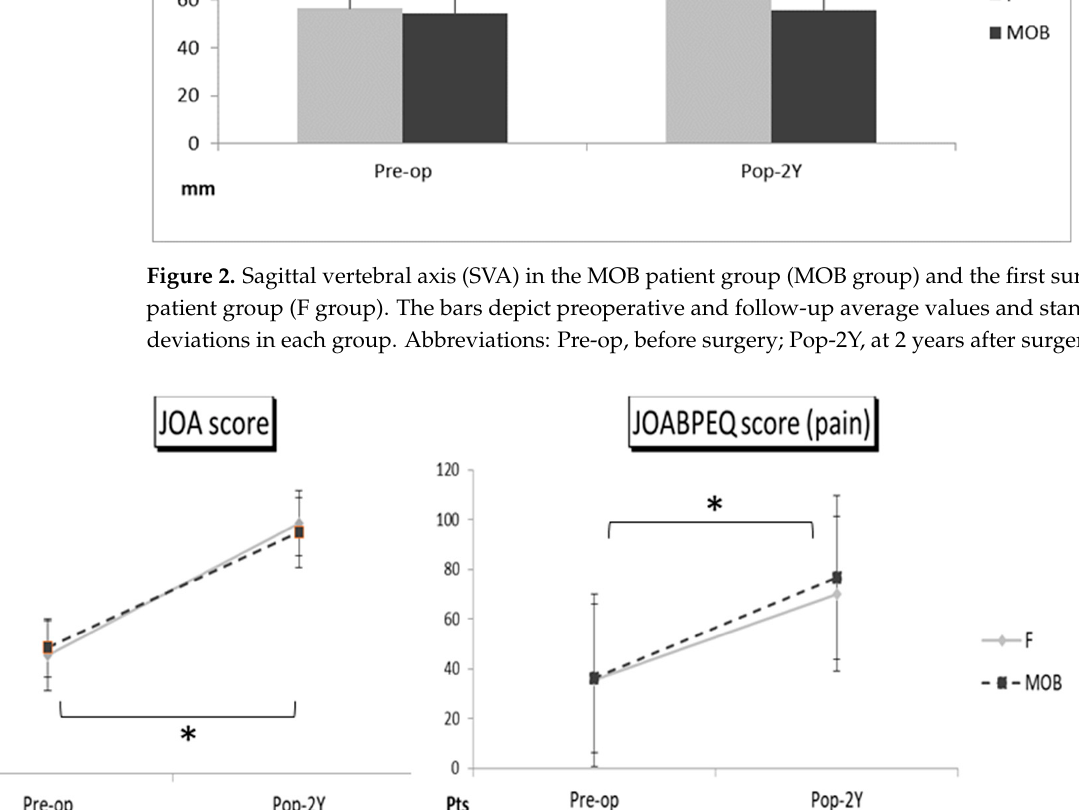
Figure 3. The JOA score and the JOABPEQ score at follow-up in the MOB patient group (MOB group) and the first surgical patient group (F group). The bars depict preoperative and follow-up average values and standard deviations in each group. The statistically significant difference was shown with an asterisk, and the postoperative level was compared with the preoperative level at p < 0.05. Comparing clinical outcomes, the JOABPEQ and the JOA scores were significantly improved at the two-year follow-up compared with the preoperative level in both groups, but there was no significant difference between the two